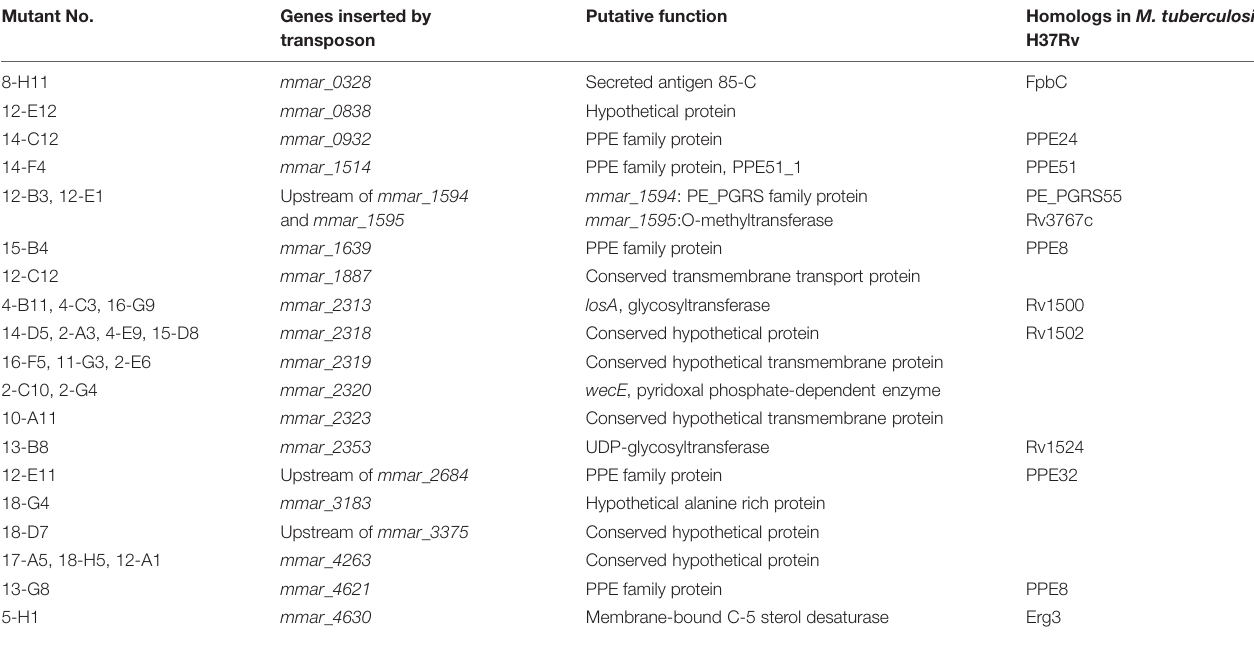
TABLE 2 | Transposon mutants permissive for Dictyostelium growth. Mutant